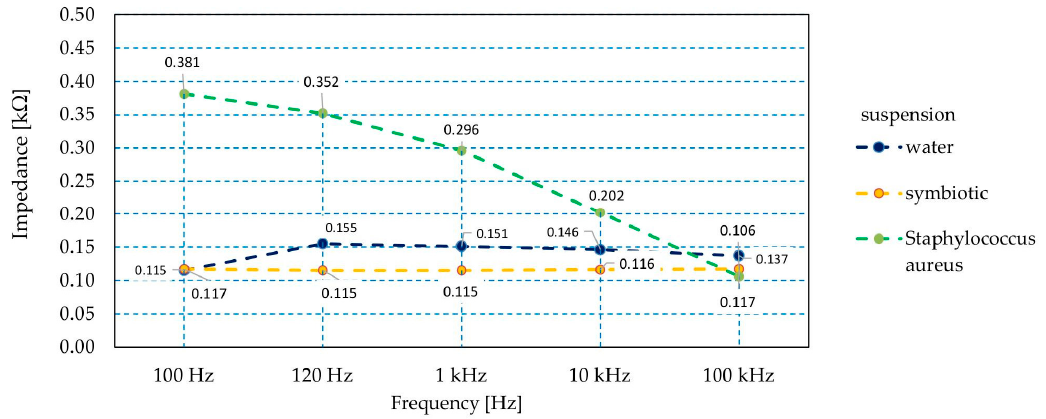
Figure 13. The dependence of the sensor impedance with regard to frequency in various types of suspensions.